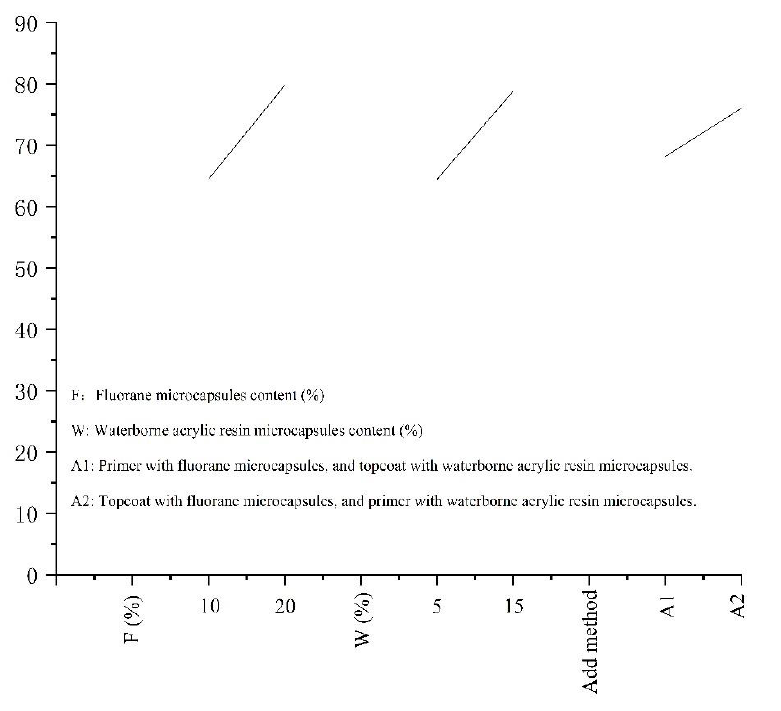
Figure 5. Results of orthogonal experiment.